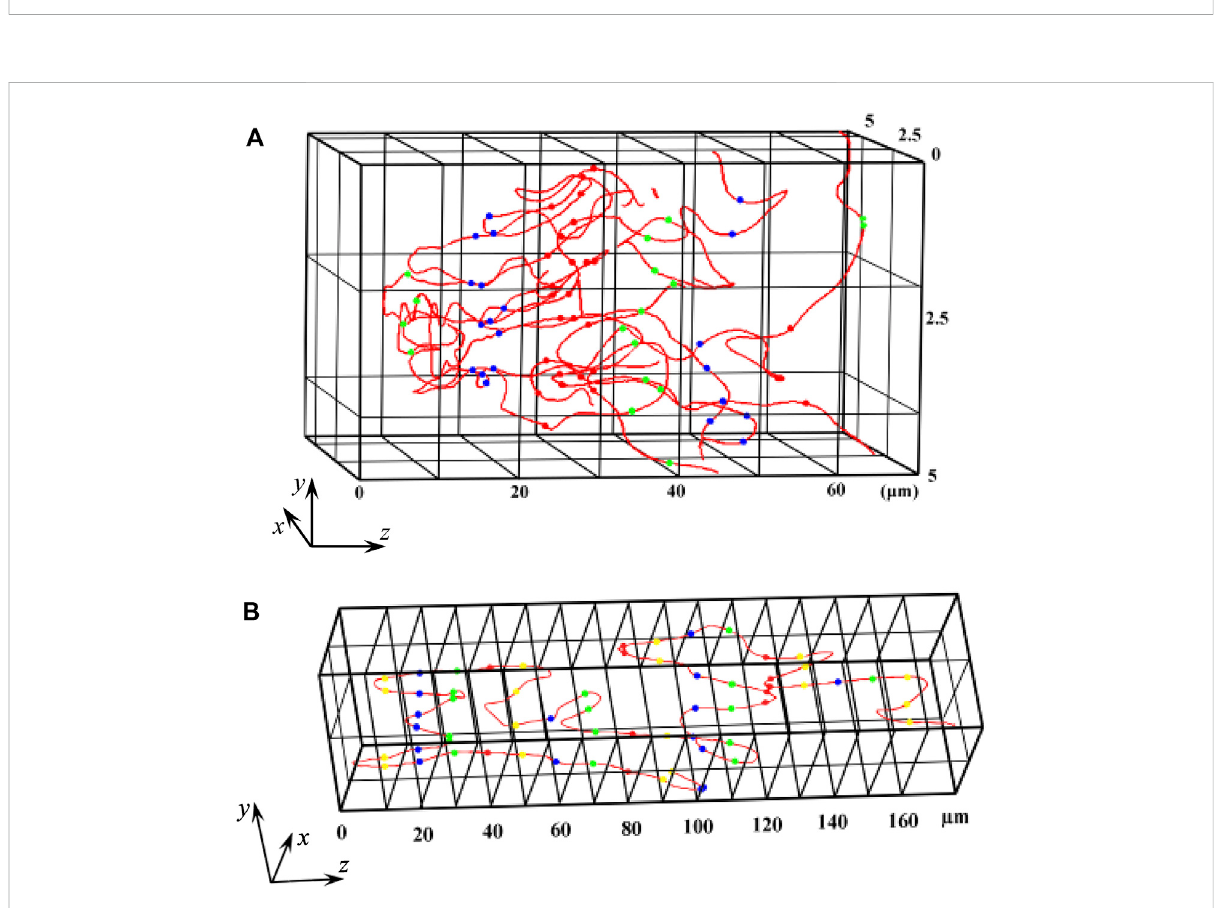
FIGURE 9 Examples of the singular lines forming the skeleton of a fi eld scattered by a rough (A) non-fractal and (B) fractal